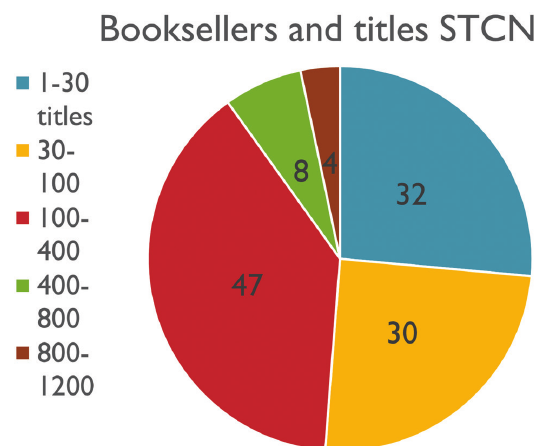
Figure 1: The size of booksellers, based on their number of titles in the